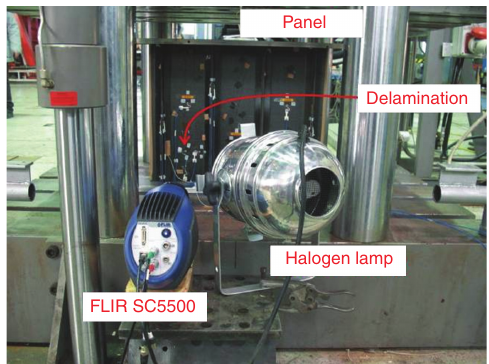
Figure 6 Setup for the nondestructive lock-in thermography